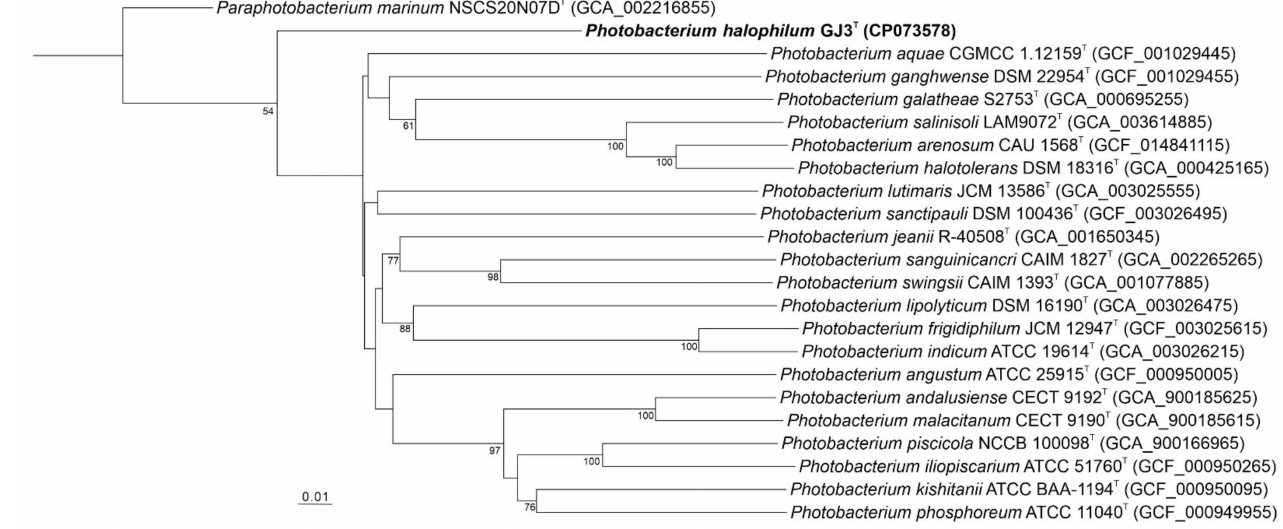
Figure 2. Whole-genome sequence-based tree inferred with FastME 2.1.6.1 [49] from GBDP dis- tances calculated from strain GJ3 T and relative genome sequences. The branch lengths are scaled in terms of GBDP distance formula d 5 . Numbers above branches are GBDP pseudo-bootstrap support values > 60% from 100 replications, with average branch support of 55.6%. The tree was rooted at the midpoint